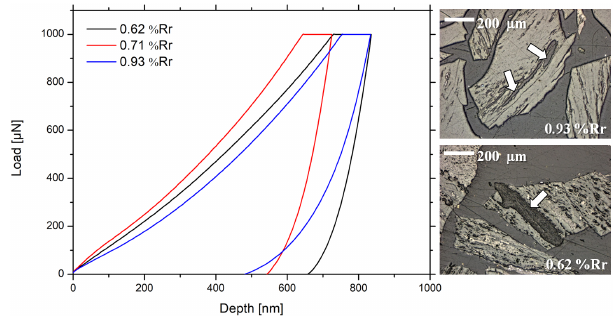
Figure 10. Averaged load-displacement curves for sporinites at dif- ferent coal ranks. The insets show micrographs of sporinites at low- medium (0.62%Rr) and high rank